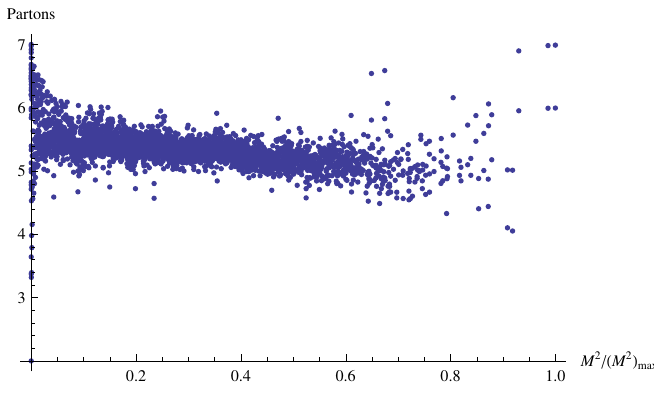
Figure 17 . Parton number vs. mass for K =